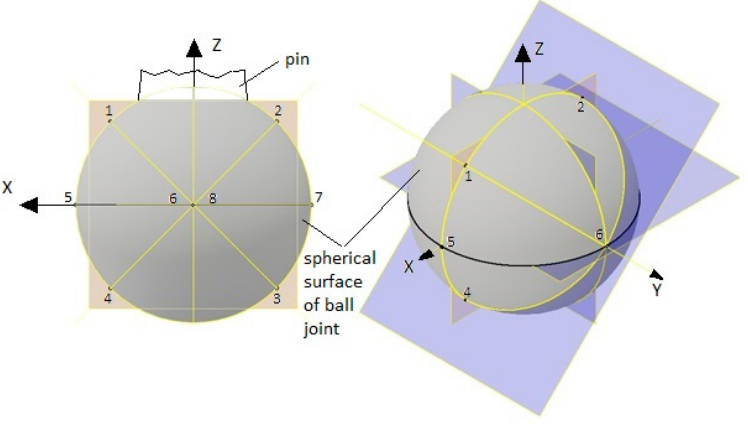
Figure 4. Points 1–8 showing roughness measurement points on the spherical surface of a ball joint.